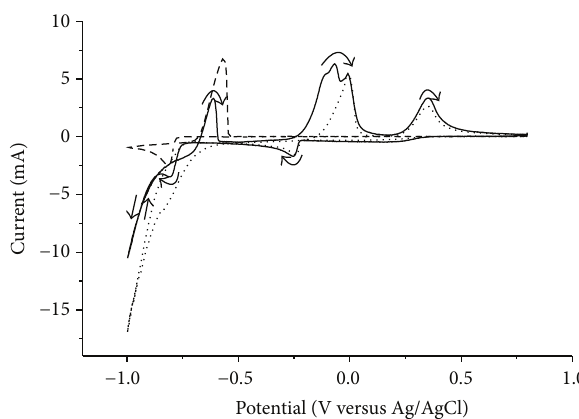
Figure 2: Voltammogram of a solution containing copper(II), indium(III), and gallium(III) (solid line) compared to a solution containingonlycopper(II)(dottedline)orindium(III)(dashedline) at a scan rate of 100 mV/s.